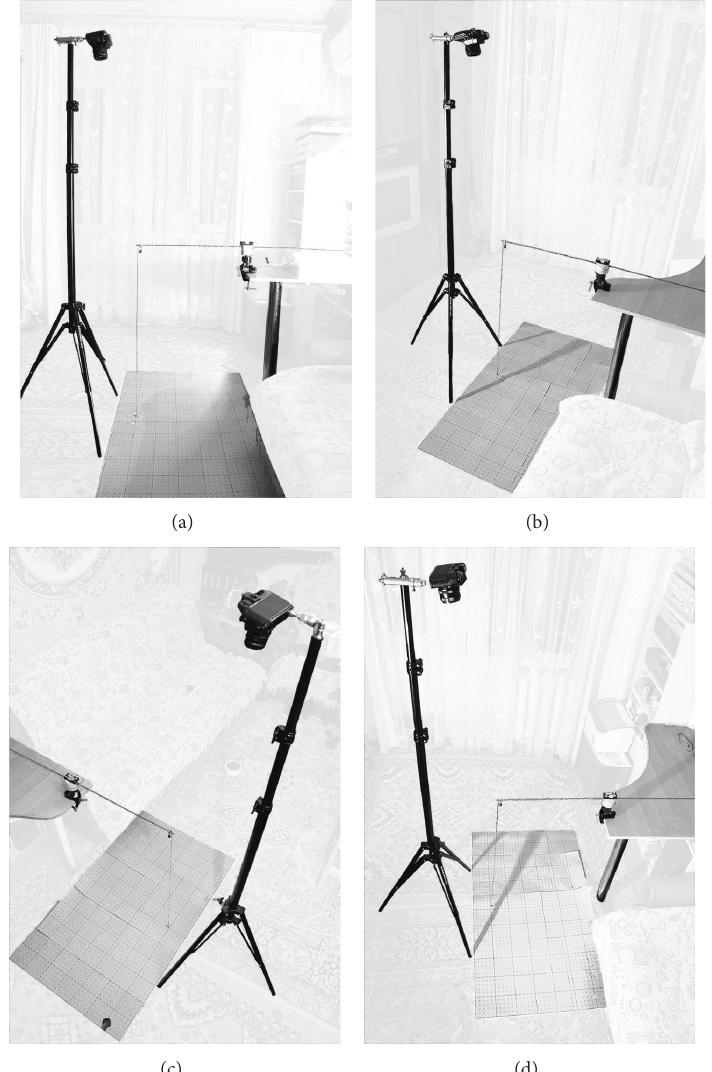
Figure 3: Photos of dimension experimental measurement system (a)–(d) for payload 𝑀 swaying motion during crane boom uniform